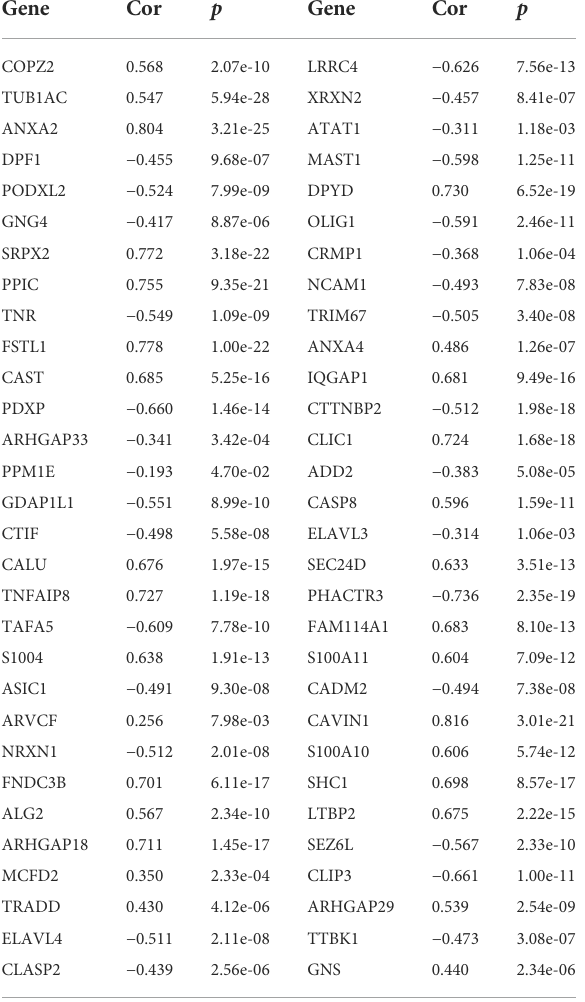
TABLE 1 Correlation analysis of GPX8 and related genes in primary GBM samples ( n = 140) from the CGGA database. Gene Cor p Gene Cor